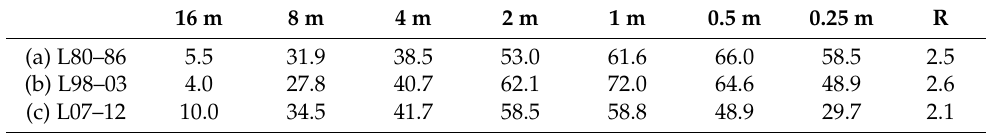
Table 1. Average vegetation profiles by layer (percentages averaged over six consecutive years) on transect L at three periods (L80–86 refers to the years 1980–1986, etc.). The period 12–17 years after the first fire (b) shows a slight deficit in the upper layers relative to the unburned control (a), the period 21–26 years later (c) shows an excess in the upper layers and a deficit in the lower layers.